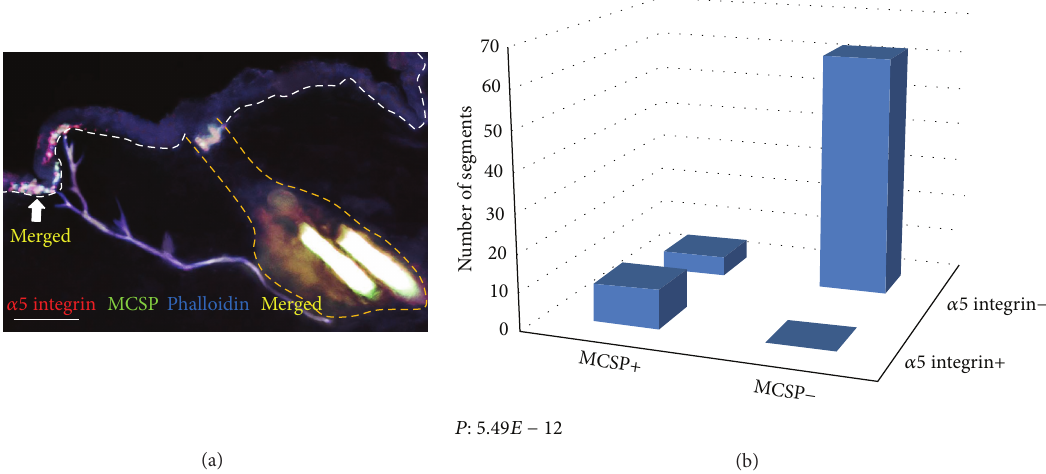
Figure 5: Localization of MCSP in the interfollicular epidermis. Immunofluorescence microscopy showing patterns of expression of MCSP, phalloidin, and K15. (a) Significant MCSP (green) and 𝛼 5 integrin (red) colocalization (yellow) was noted in the interfollicular epidermis. (b) A strong correlation between 𝛼 5 integrin and MCSP was seen suggesting that cells expressing MCSP in the basal epidermis are located in close proximity to the attachments sites of the APM. Scale bar: 100 𝜇